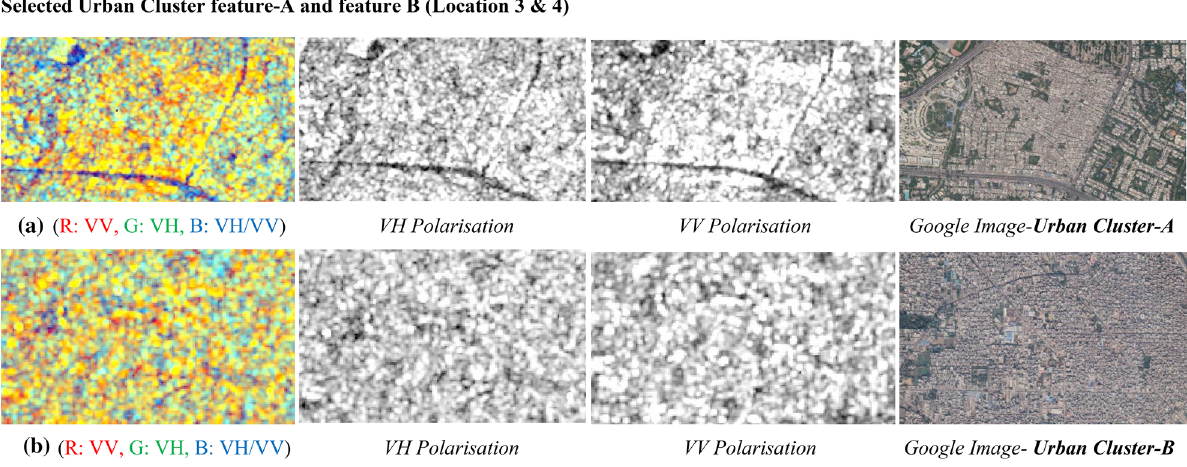
Figure 25. Colour composite image of the Sentinel-1 C-band data, dual-polarization data, and Google Image for site A & B.